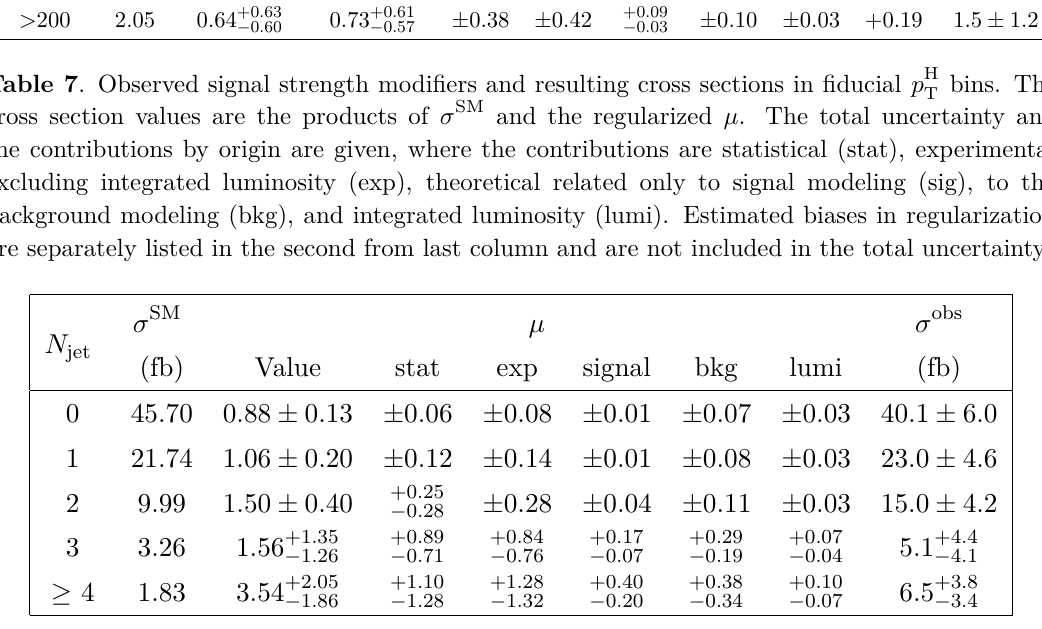
Table 8 . Observed signal strength modifiers, uncertainties, and resulting cross sections in fidu- cial N bins. The cross section values are the products of σ SM and the unregularized µ . The jet uncertainties are separated by origin as in table